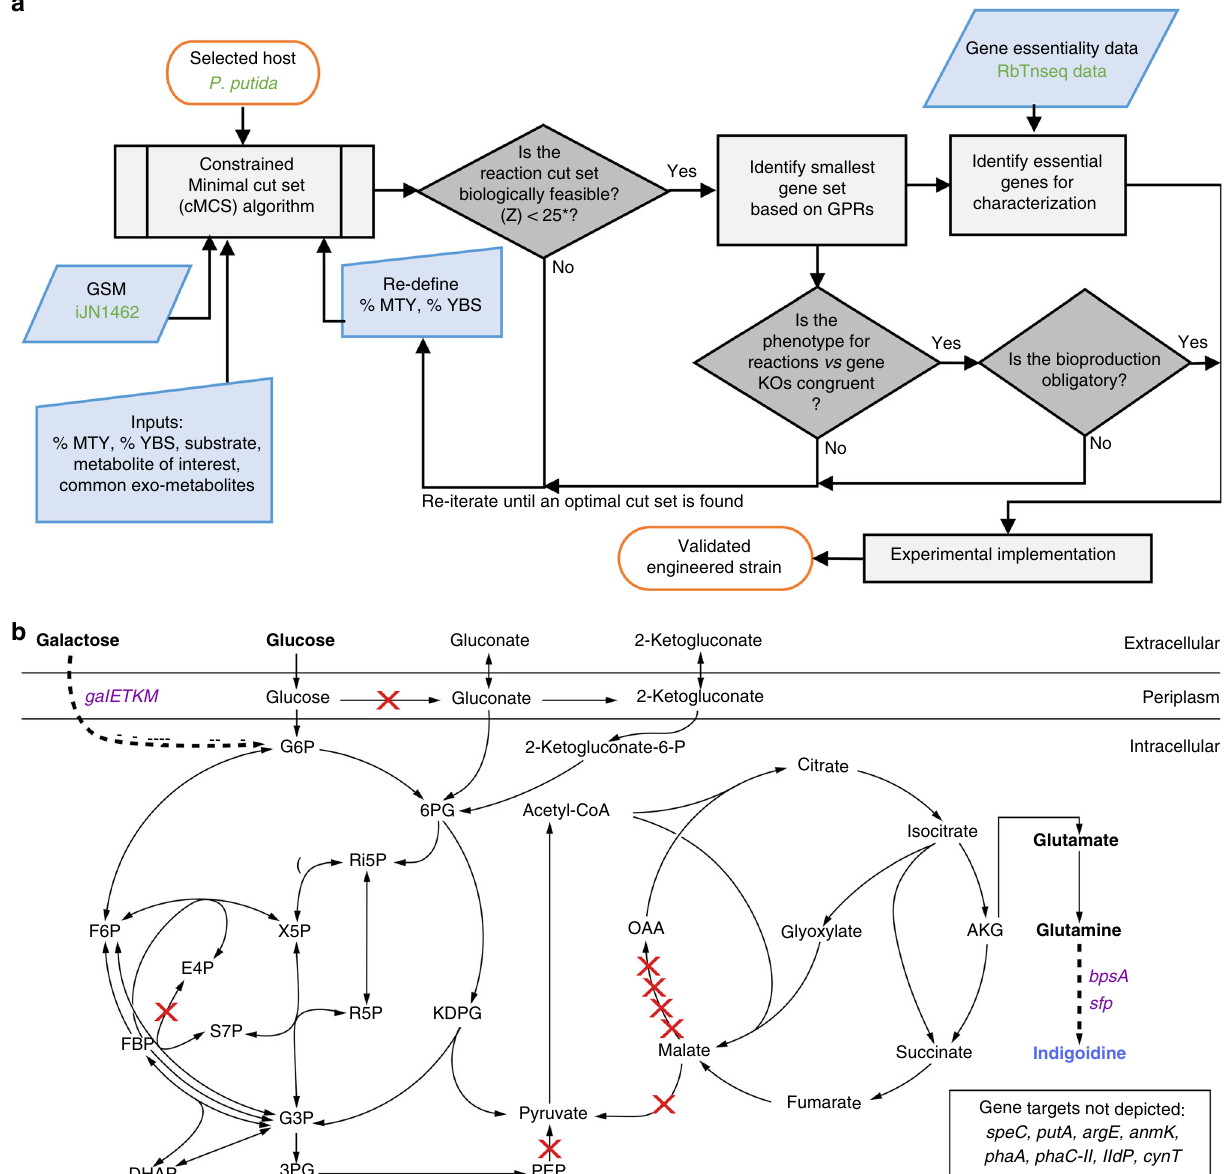
Fig. 1 Computationally guided predictions for metabolic rewiring in P. putida . a Modeling and engineering work fl ow diagram. This approach can potentially be extended to any carbon source, host and/or metabolite. Input speci fi c to this speci fi c host/ fi nal product work is marked in green font. b The central metabolism of P. putida engineered to produce indigoidine from either glucose or galactose. Heterologous genes are indicated in purple text. Indigoidine is derived from the TCA intermediate α -ketoglutarate (AKG) via two molecules of glutamine. The genes targeted in P. putida central metabolism for knockdown by dCpf1/ CRISPRi are indicated with red X marks. Additional gene targets outside of P. putida central metabolism are indicated in the box on the bottom right. A total of 14 genes were targeted for CRISPR interference excluding mqo-I and cynT , as the latter are essential by genome-wide transposon mutagenesis (RB-TnSeq). Abbreviations include Genome-scale Model (GSM), maximum theoretical yield (MTY), size of reaction cut set (Z), Gene – protein-reaction relationships (GPRs), knockout (KO), biomass yield (YBS), glucose-6-phosphate (G6P), fructose-6-phosphate (F6P), fructose-1,6-biphosphate (FBP), 6-phosphogluconate (6PG), 2- keto-3-deoxy-6-phosphogluconate (KDPG), ribulose-5-phosphate (Ri5P), ribose-5-phosphate (R5P), xylulose-5-phosphate (X5P), sedoheptulose-7-phosphate (S7P), erythrose-4-phosphate (E4P), glyceraldehyde-3-phosphate (G3P), glycerate-3-phosphate (3PG), dihydroxyacetone phosphate (DHAP), phosphoenolpyruvate (PEP) and oxaloacetate (OAA). Refer to Supplementary Fig. 1 and Supplementary Data 1 for more